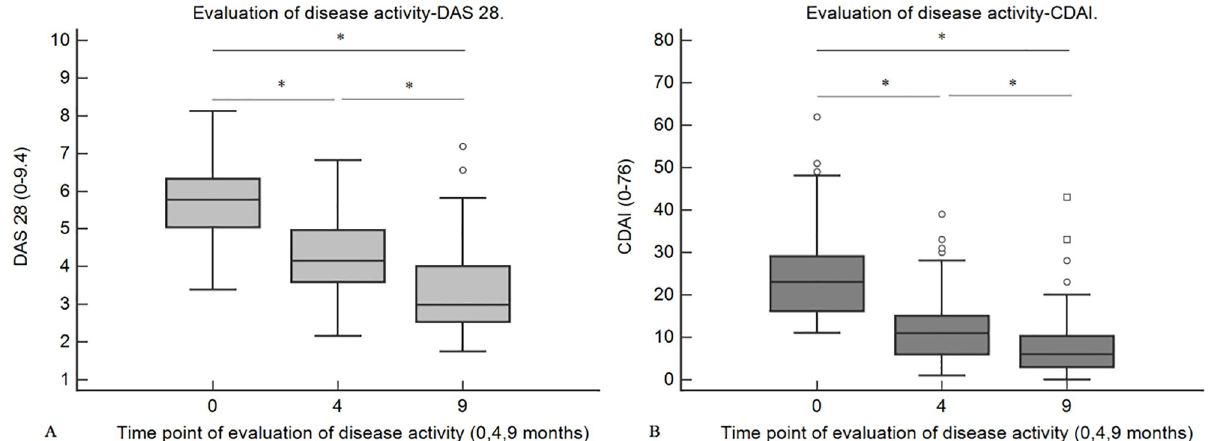
Fig 1. Box and whisker plots illustrating the changes in the disease activity in the patient cohort as assessed by CDAI (a) and DAS 28 (b). The median disease activities at different time points were compared by the Kruskal-Wallis test (with Dunn’s post-hoc analysis). The drops in the median disease activity down the timeline were statistically significant (p < 0.05). Asterix indicate that the difference between groups is statistically significant. DAS 28 –disease activity score 28, CDAI- clinical disease activity index, 0, 4, and 9 in the x-axis indicate the time point of evaluation (0 –baseline, 4–4 months, and 9–9